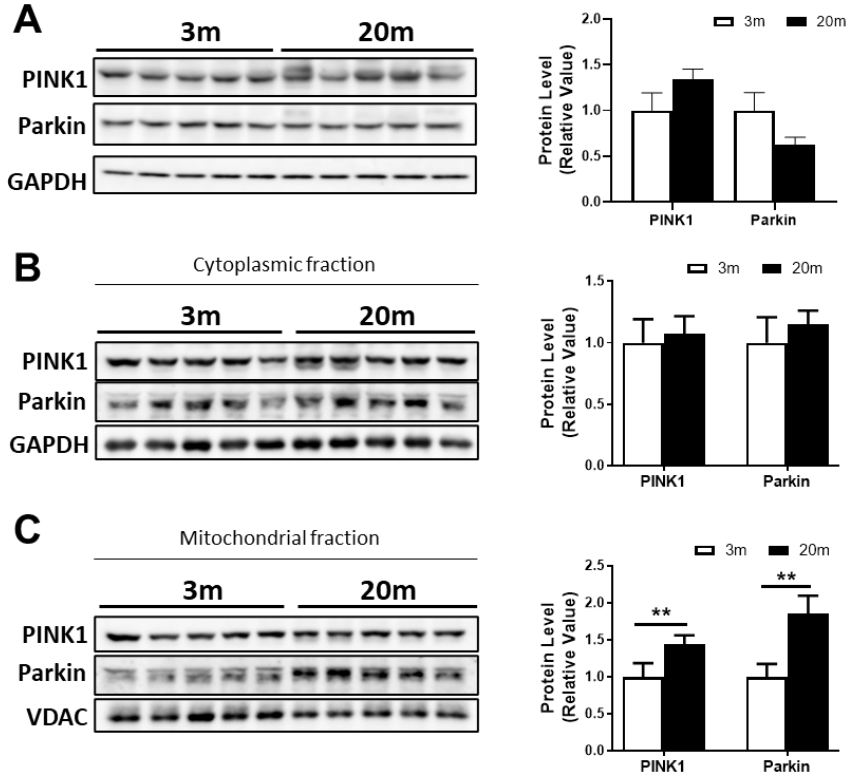
Figure 6. PINK1 and Parkin levels are increased in the mitochondria of the hippocampus of aged female C57BL/6J mice. Western blot and densitometric analysis of PTEN-induced kinase 1 (PINK1) and Parkin levels in ( A ) total lysate and ( B ) cytoplasmatic and ( C ) mitochondrial fraction of hippocampus. Densitometric analysis is expressed as levels relative to control. Graph bars represent means ± SEM. ** p < 0.01.